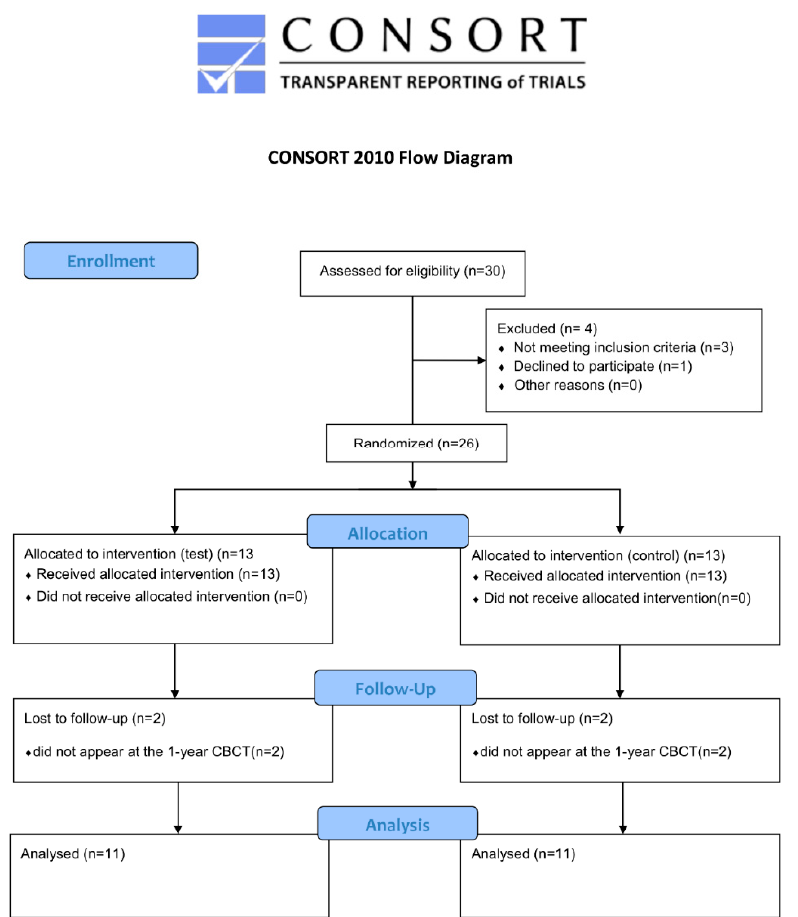
Figure 1. CONSORT flow diagram.